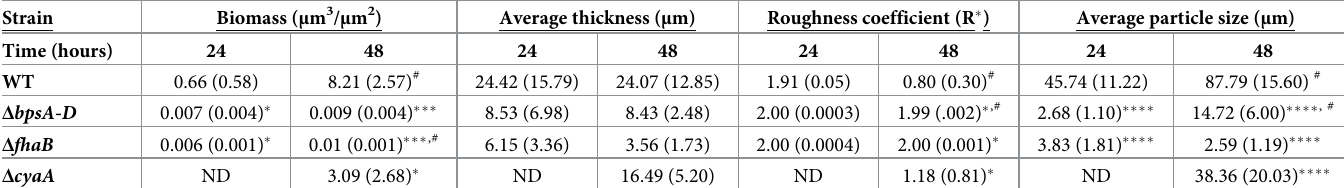
Table 2. COMSTAT analysis of CLSM images. Values correspond to Fig 4A–4L, 5C, and 5D. Mean values are represented, with standard error of the mean values in parentheses. Data represent at least two independent experiments. To compare mutants to WT, significance was calculated by using one-way ANOVA and Dunnett’s post hoc: � , p < 0.05; �� , p < 0.01, ��� p < 0.001; ���� , p < 0.0001. To compare 24 h to 48 h, significance was calculated using unpaired Student’s t- test: # , p < 0.05.